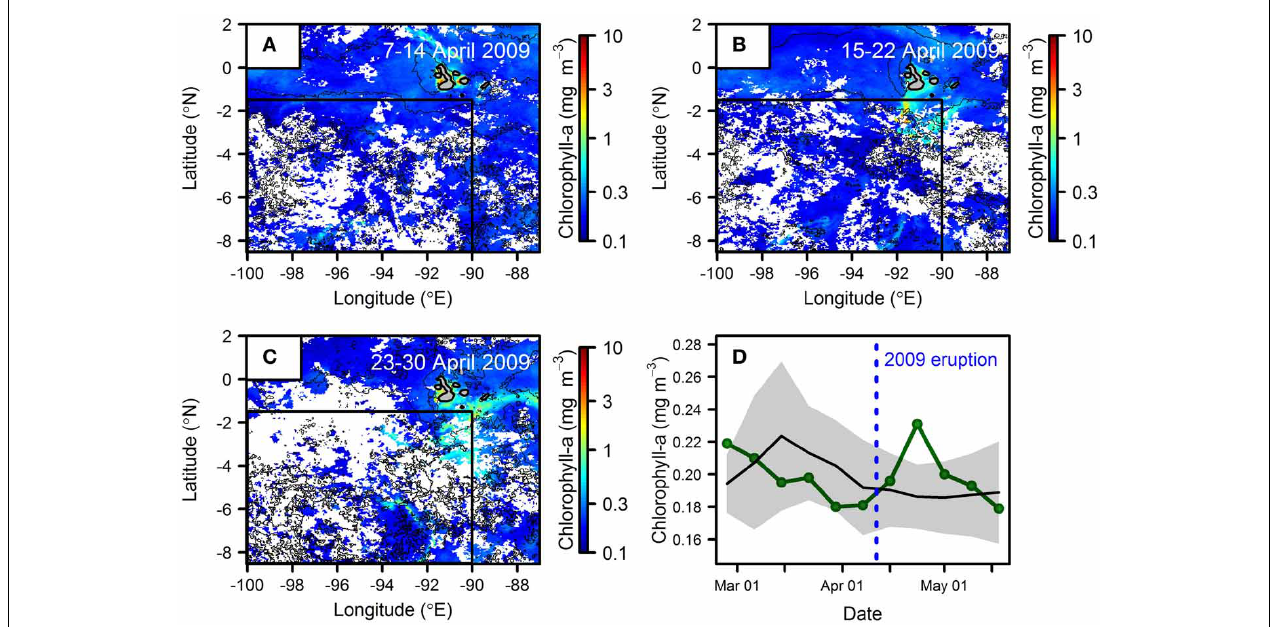
FIGURE 5 | Chlorophyll-a concentrations before and after the 2009 eruption of La Cumbre, Galapagos Islands. (A–C) 8-day chlorophyll-a composites for the time period (A) before, and (B,C) after the eruption for which an ash cloud was projected to extend westward. Narrow black lines